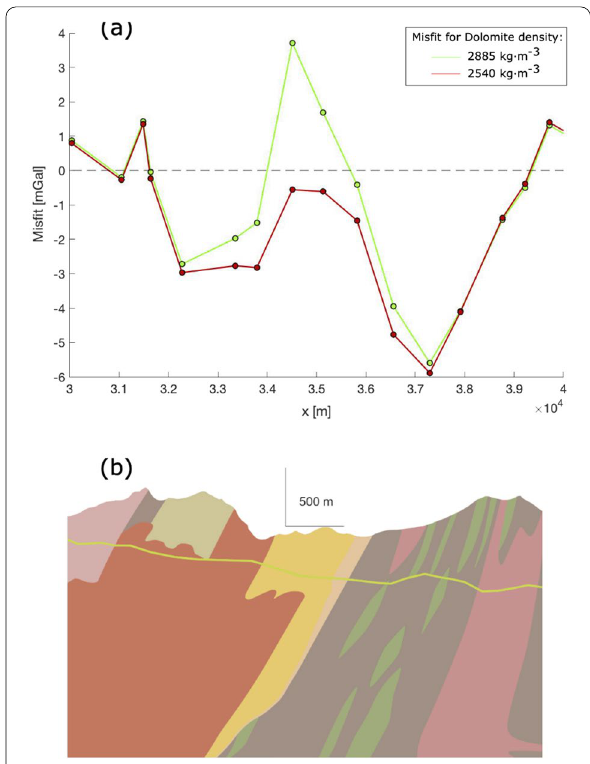
Fig. 9 Gravity effect due to a density variation of ∼ 300 kg · m − 3 of a middle-size unit (Piora Dolomite), presenting a ∼ 600 m topographic adaptation. a Gravity misfits, defined as the difference between synthetic values and corrected observations, for a higher density value of 2885 kg · m − 3 (green line and dots) and for a lower density value of 2540 kg · m − 3 for the Dolomite unit (yellow unit in panel b ). The remaining unit densities are unvaried. b Geological profile as projected along the straight reference model line. The green line is the reference topography, and separates the modelled geological units below and the original model that includes the parts above. The latter excess is removed and accounted for by the TAC correction in the transition from the 3D to the 2.5D